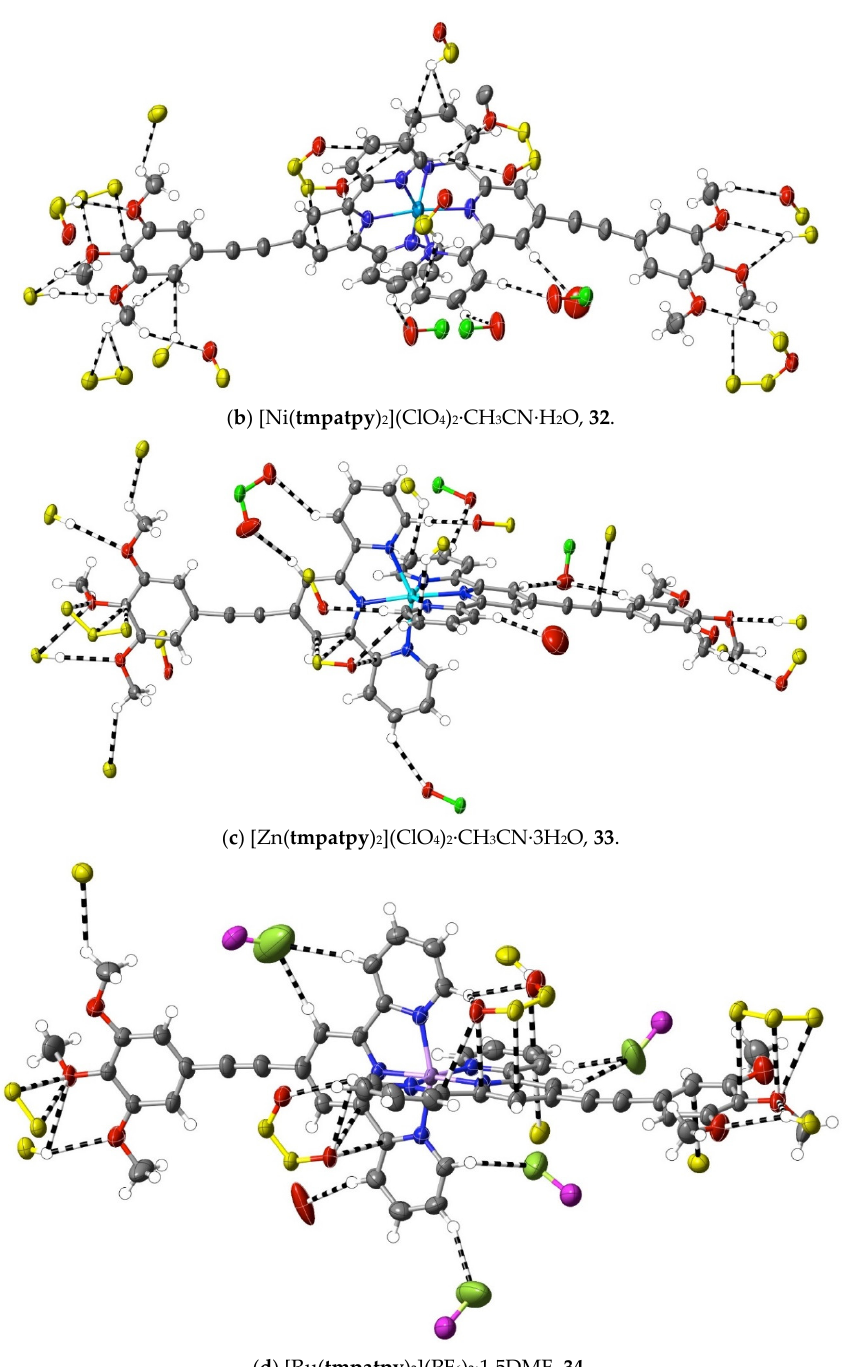
Figure 10. Interactions beyond dispersion of complex cations incorporating trimethoxyphenyl-substituted 2,2 ′ :6 ′ ,2 ″ -terpyridine ligands.